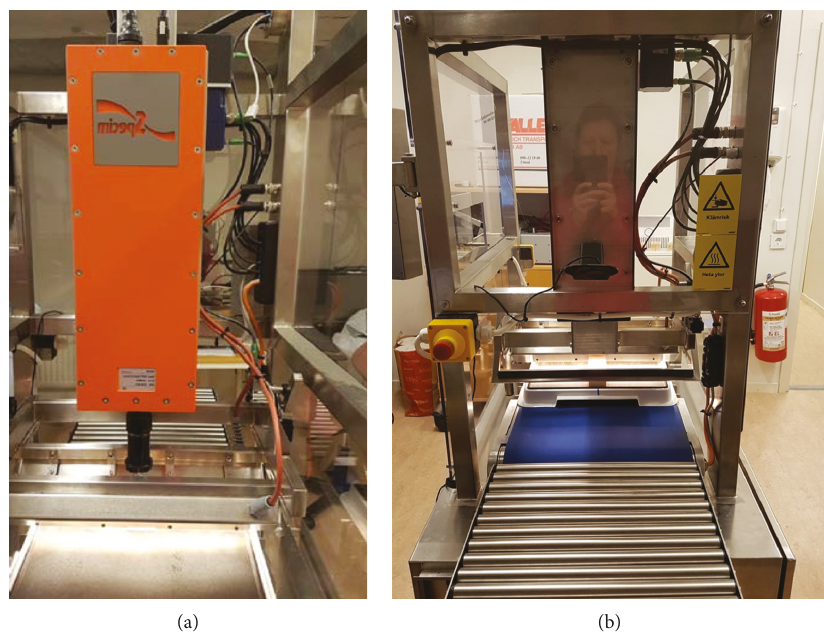
Figure 2: Test setup for wood imaging: (a) the spectral camera and (b) the conveyer belt for sample movement. Table 1: The random positions of specimens from naturally seasoned and kiln-dried specimens. Cross-sectional